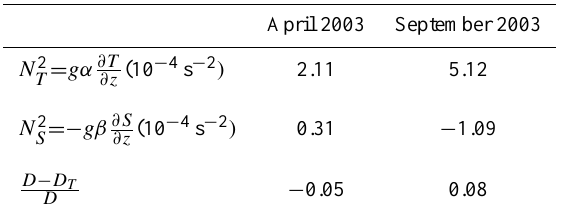
Table A1. The depth-averaged contributions of temperature and salinity to the vertical stratification in the 0 to 35m depth